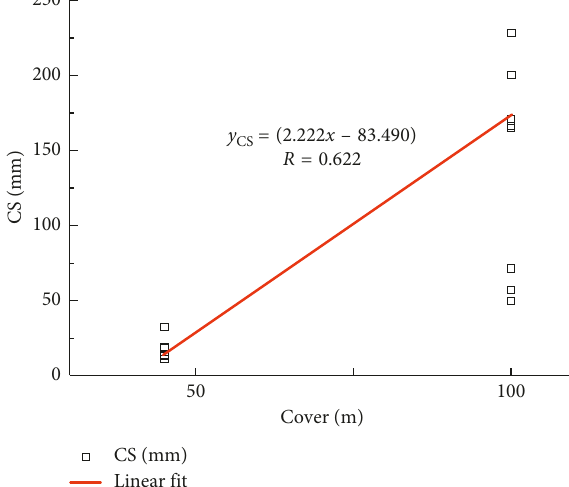
Figure 10: Linear regression between CS and cover depth at 12.26 span.